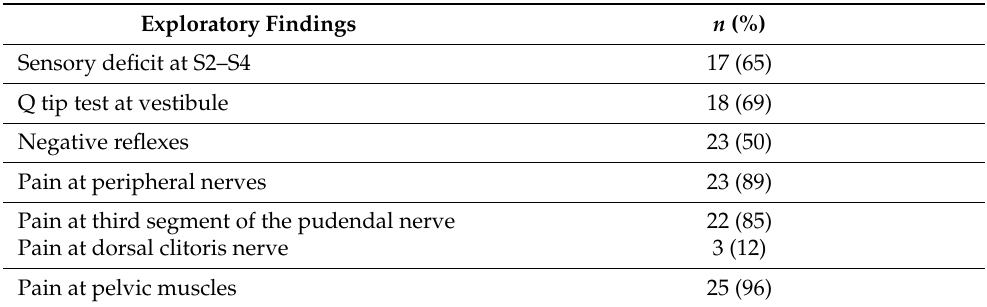
Table 2. Descriptive analyses with examination findings of endometriosis patients unresponsive to conventional